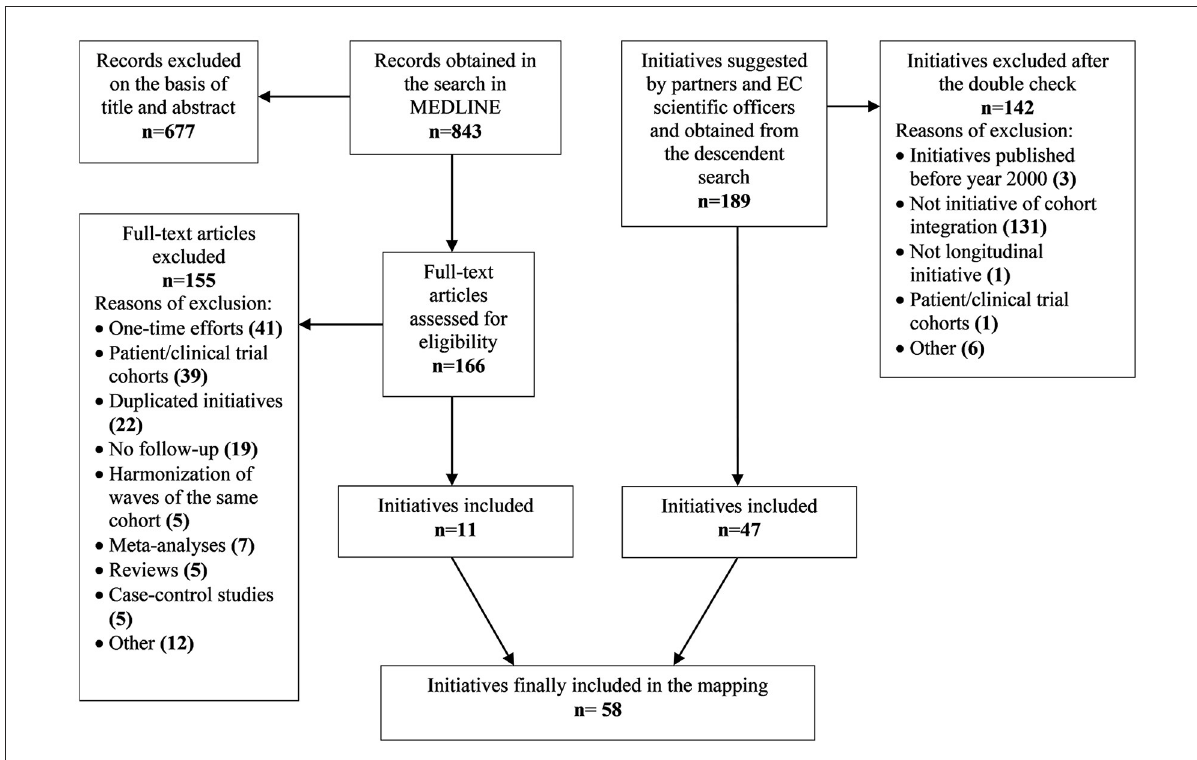
FIGURE1 Flowchart diagram detailing the initiatives included and